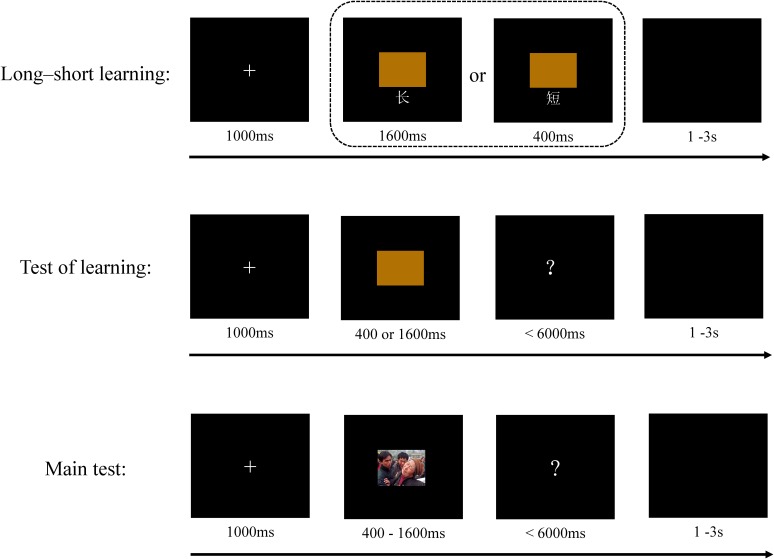
Schematic illustration of the temporal bisection task.